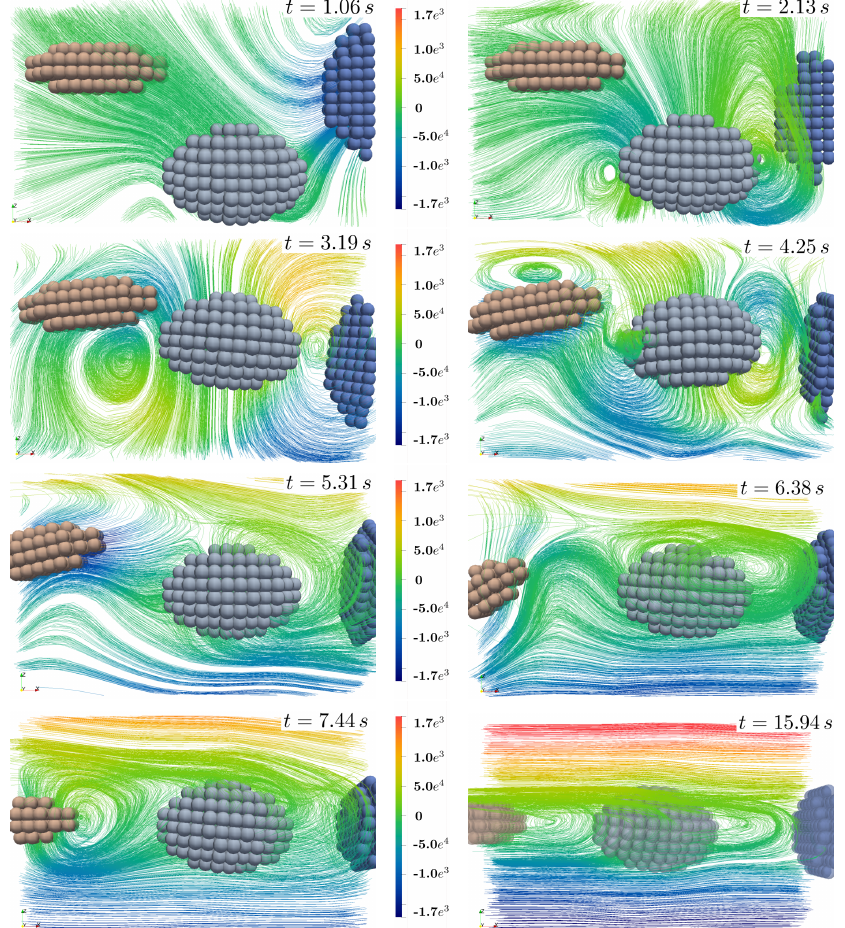
Figure 13. Streamlines of the velocity v x -direction at various time steps considering the e x - e x -plane for simulation containing four ellipsoidal solid particles.